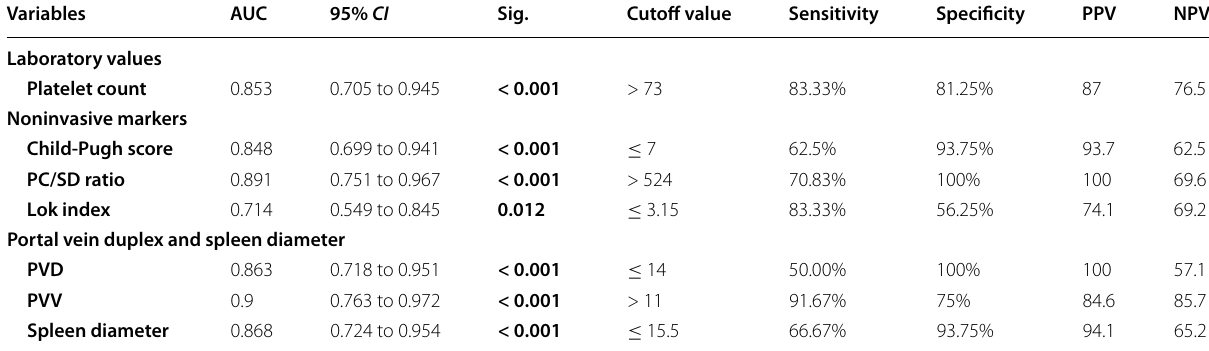
Table 7 ROC curve predicting reversibility of portal hypertension in patients with HCV‑related cirrhosis with CSPH Variables AUC 95% CI Sig. Cutoff value Sensitivity Specificity PPV NPV